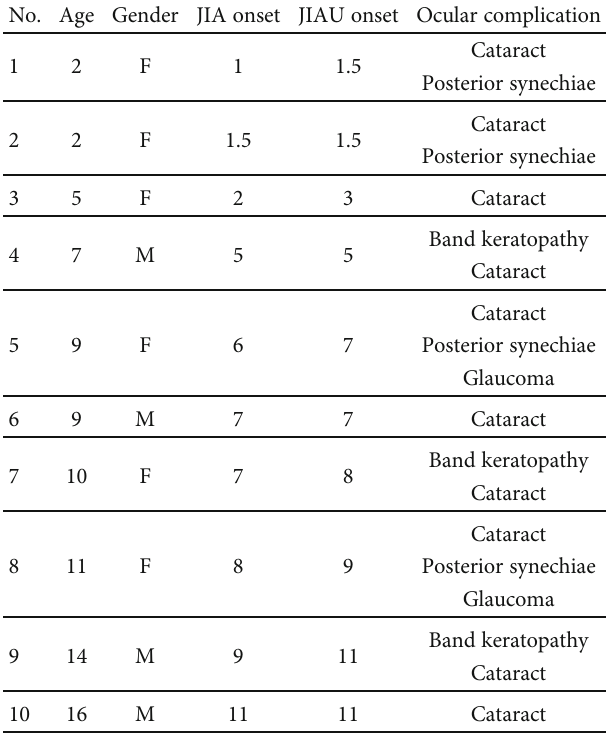
Table 1: Information of the ANA+